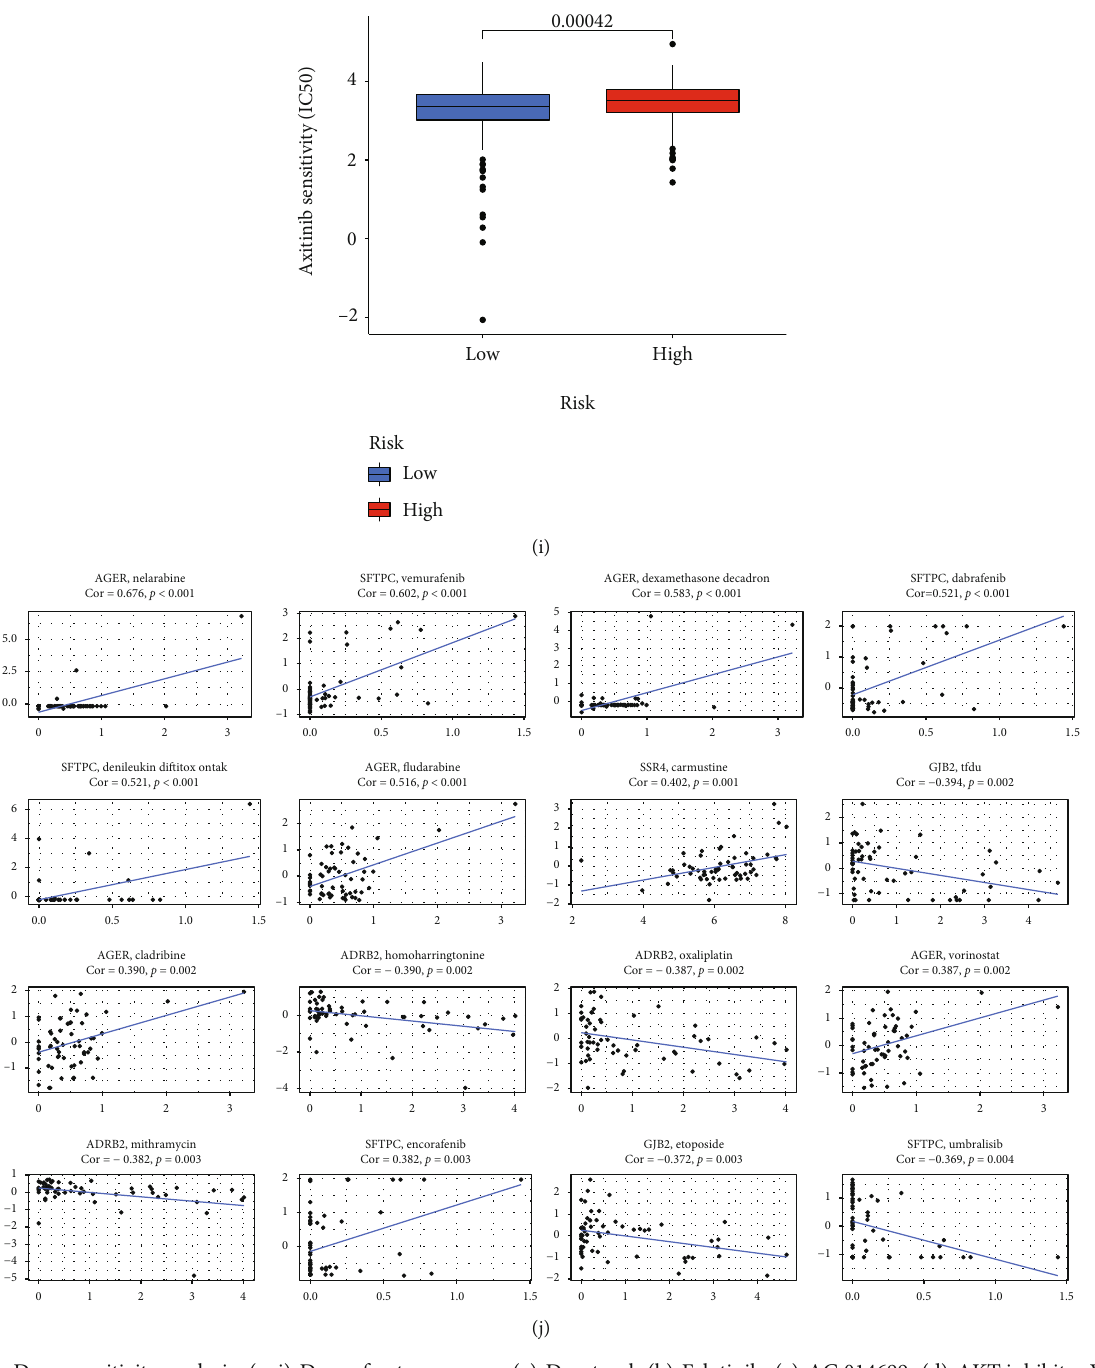
Figure 7: Drug sensitivity analysis. (a – i) Drugs for two groups. (a) Docetaxel. (b) Erlotinib. (c) AG.014699. (d) AKT.inhibitor.VIII. (e) Embelin. (f) ABT.888. (g) AS601245. (h) ATRA. (i) Axitinib. (j) Multiple drugs for eight signature